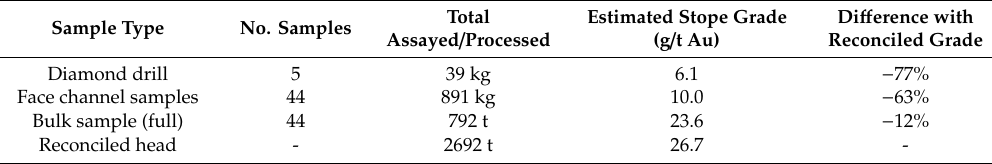
Table 23. Comparison between diamond drill, channel samples and bulk sample estimates for the Veta Christina south trial (1-2 level) stope panel with the plant head grade. All estimated grades account for intentional and unintentional